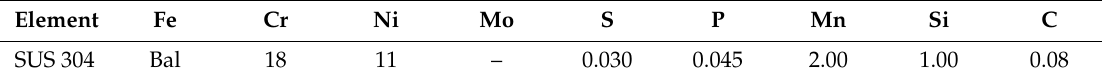
Figure 1. SEM morphology of TiO 2 powder. Table 1. Material chemical composition [wt%].